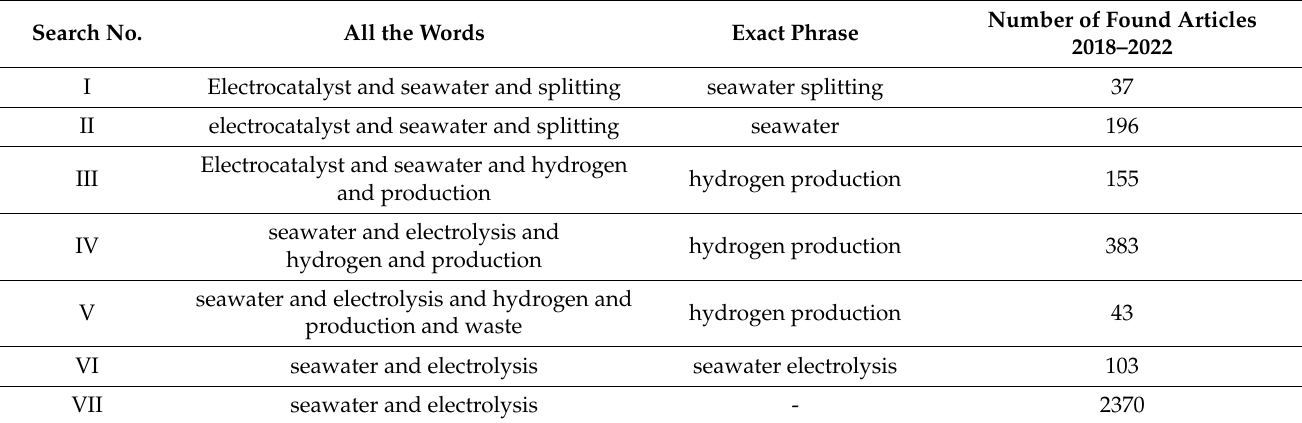
Table 9. Search key words for studies published during the period 2018–2022. Search No.